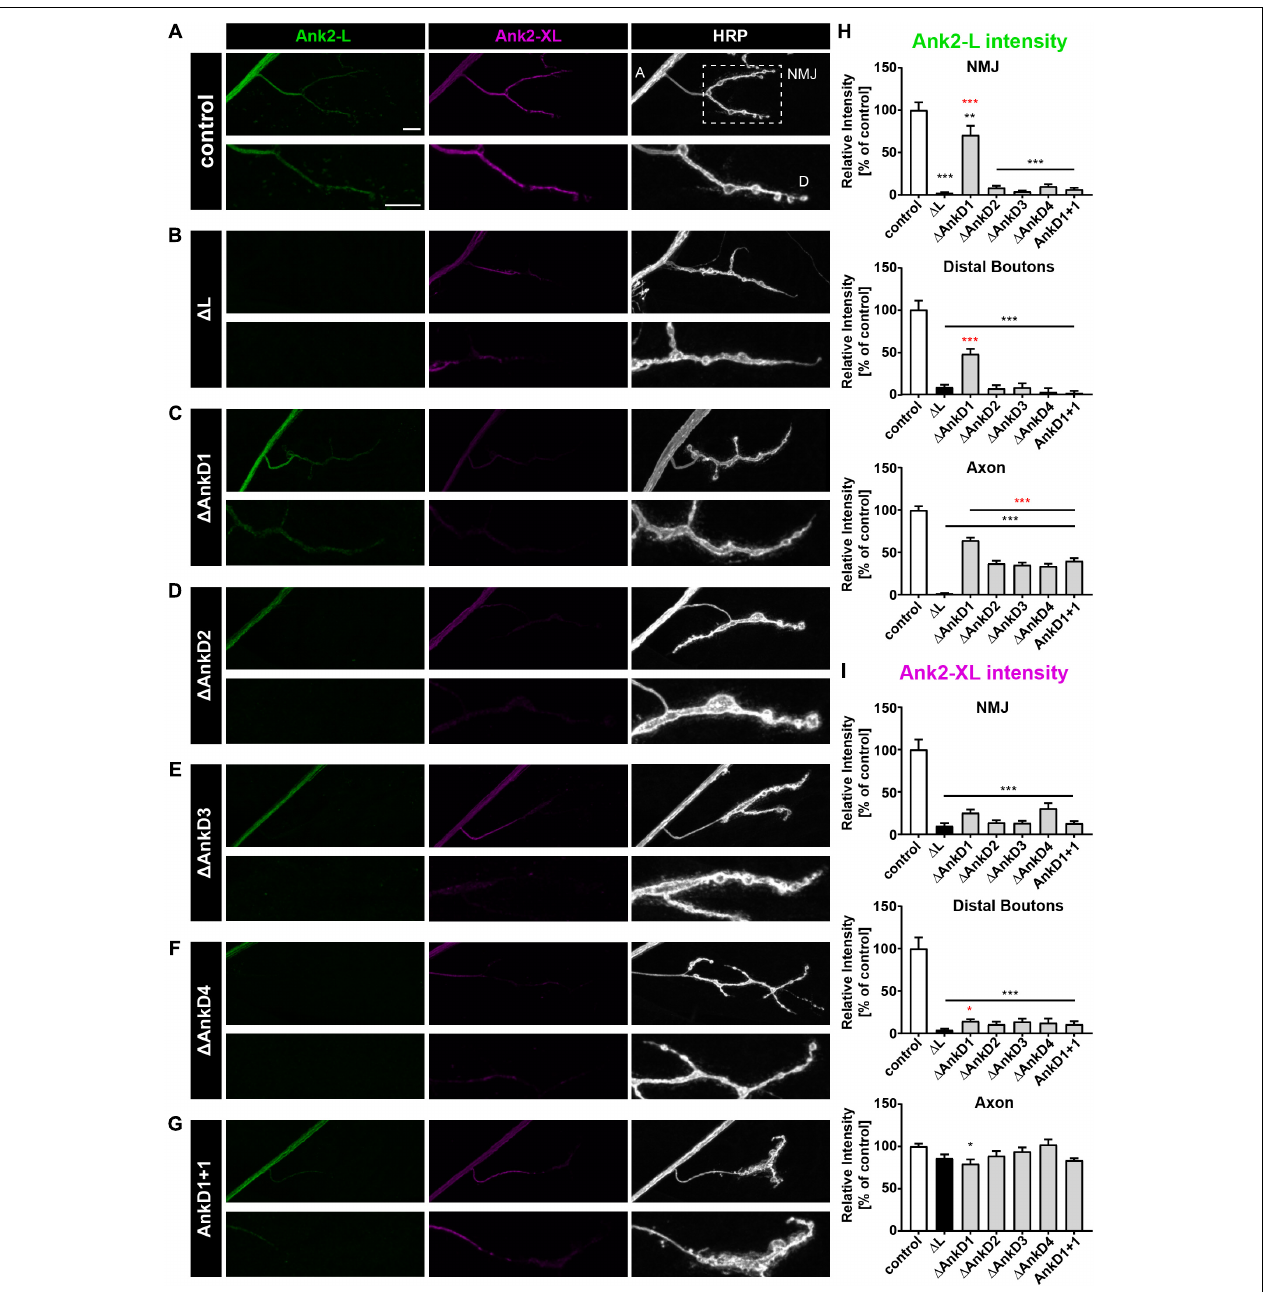
FIGURE 2 | Analysis of ARD-dependent localization of Ank2-L and Ank2-XL in ank2 (cid:49) L mutants. (A–G) Analysis of Ank2-L (green) and Ank2-XL (magenta) localization at muscle 4 NMJs (HRP, white). (A) In control animals ( P[ank2_wt] /+; ank2 (cid:49) L / ank2 null ) presence of the wild type P[acman] ank2 constructs completely restores NMJ localization of Ank2-L and Ank2-XL. Areas for quantification of intensities are indicated in the HRP channel (A, axon, D, distal bouton, NMJ). (B) In ank2 (cid:49) L /ank2 null mutant animals Ank2-L is absent and levels of Ank2-XL are severely reduced at the NMJ but not in the axon. (C–F) Analysis of the four AnkD deletion mutants ( P[ank2_ (cid:49) AnkDx] /+; ank2 (cid:49) L / ank2 null ) reveals severe perturbations of Ank2-L level at the NMJ. These effects are less severe for the AnkD1 mutation. All deletion mutations significantly reduce Ank2-XL distribution at the NMJ. (G) Analysis of the AnkD1+1 construct in which the second AnkD has been replaced by the first AnkD. Both Ank2-L and Ank2-XL distribution are perturbed comparable to the deletion of the second AnkD. (H) Quantification of Ank2-L level at the NMJ, within distal boutons and in the axon ( n = 11–12 muscle 4 NMJs, three animals/genotype). (I) Quantification of Ank2-XL level at the NMJ, in distal boutons and in the axon ( n = 11–12 muscle 4 NMJs, three animals/genotype). Scale bars in (A) apply to (A–G) and represent 10 µ m. Error bars indicate SEM; ∗ p < 0.05, ∗∗ p < 0.01, ∗∗∗ p < 0.001 (ANOVA); black asterisks represent comparisons to controls; red asterisks represent comparisons to ank2 (cid:49) L mutants.